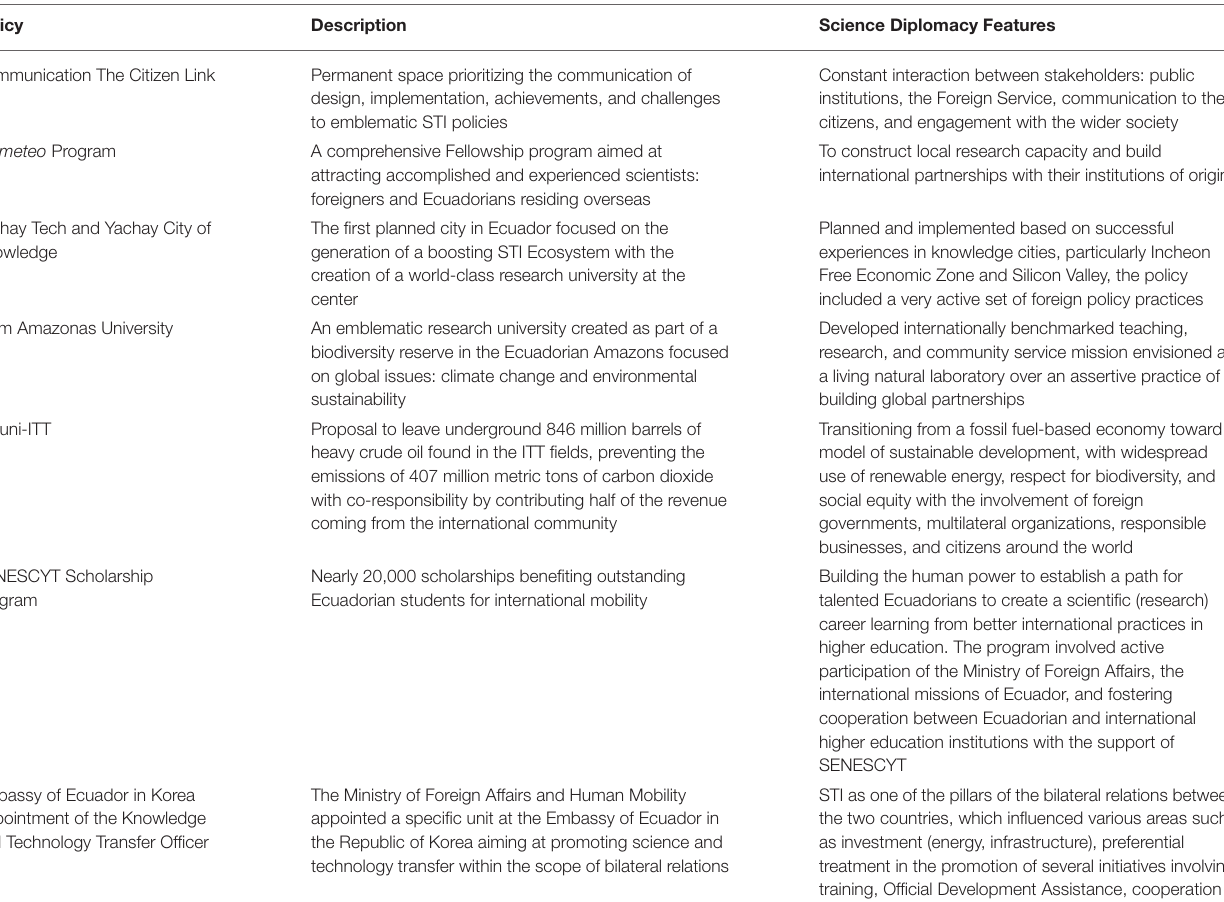
TABLE 2 | Science diplomacy and key policy practices Ecuador